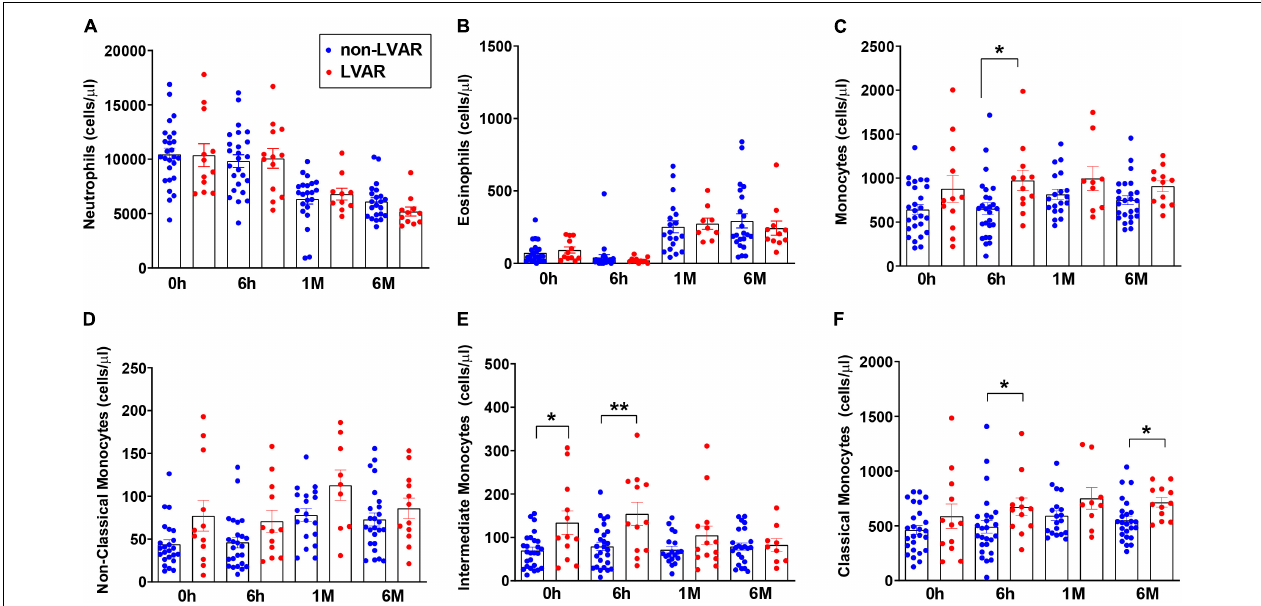
FIGURE 2 | Analysis of the level of granulocytes, monocytes and monocytes subsets in patients with or without LVAR. (A–F) Bar graphs show the level of neutrophils (A) , eosinophils (B) , total monocytes (C) and the monocyte subsets: non-classical (D) , intermediate (E) and classical monocytes (F) in PB samples of non-LVAR STEMI patients (blue dots, n = 26) and STEMI patients who developed LVAR (red dots, n = 12) at 0, 6 h, 1 and 6 months post PPCI. Data are shown as the means ± SEM. Kruskal–Wallis test with multiple comparisons corrected by Dunn’s test was performed. (*) and (**) indicate significance at p < 0.05 and p < 0.01, respectively. LVAR: left ventricle adverse remodeling; PB, peripheral blood; PPCI, primary percutaneous coronary intervention; STEMI, ST-elevation myocardial